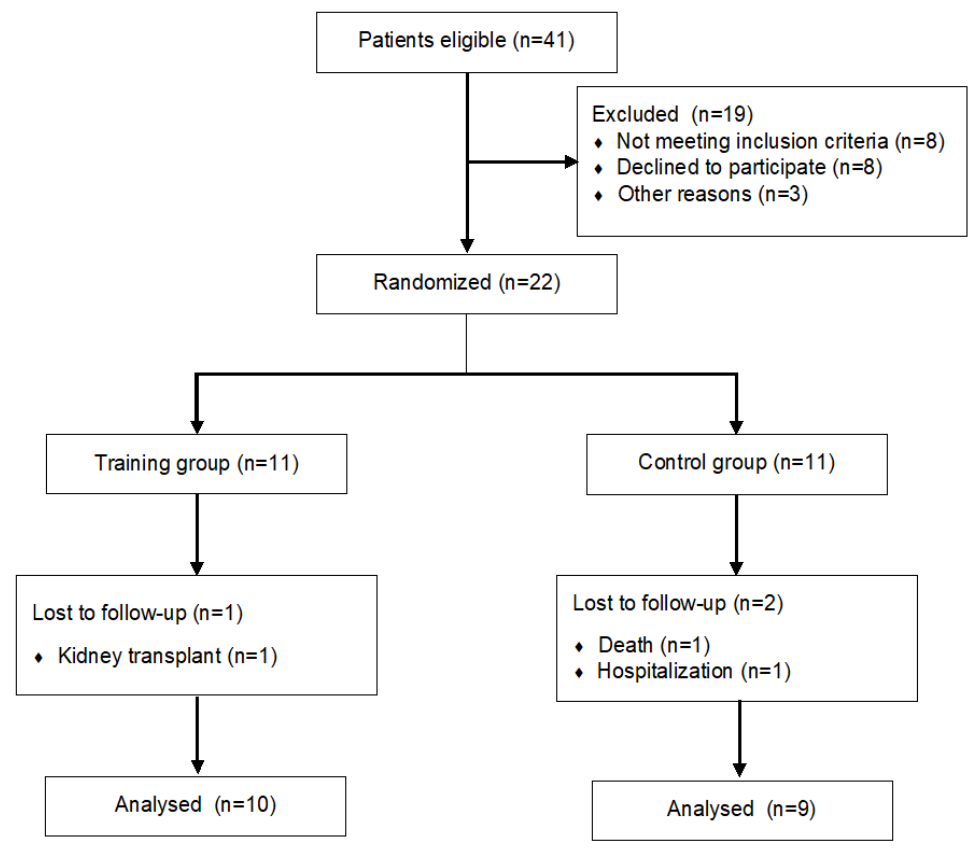
Figure 1. Study flow